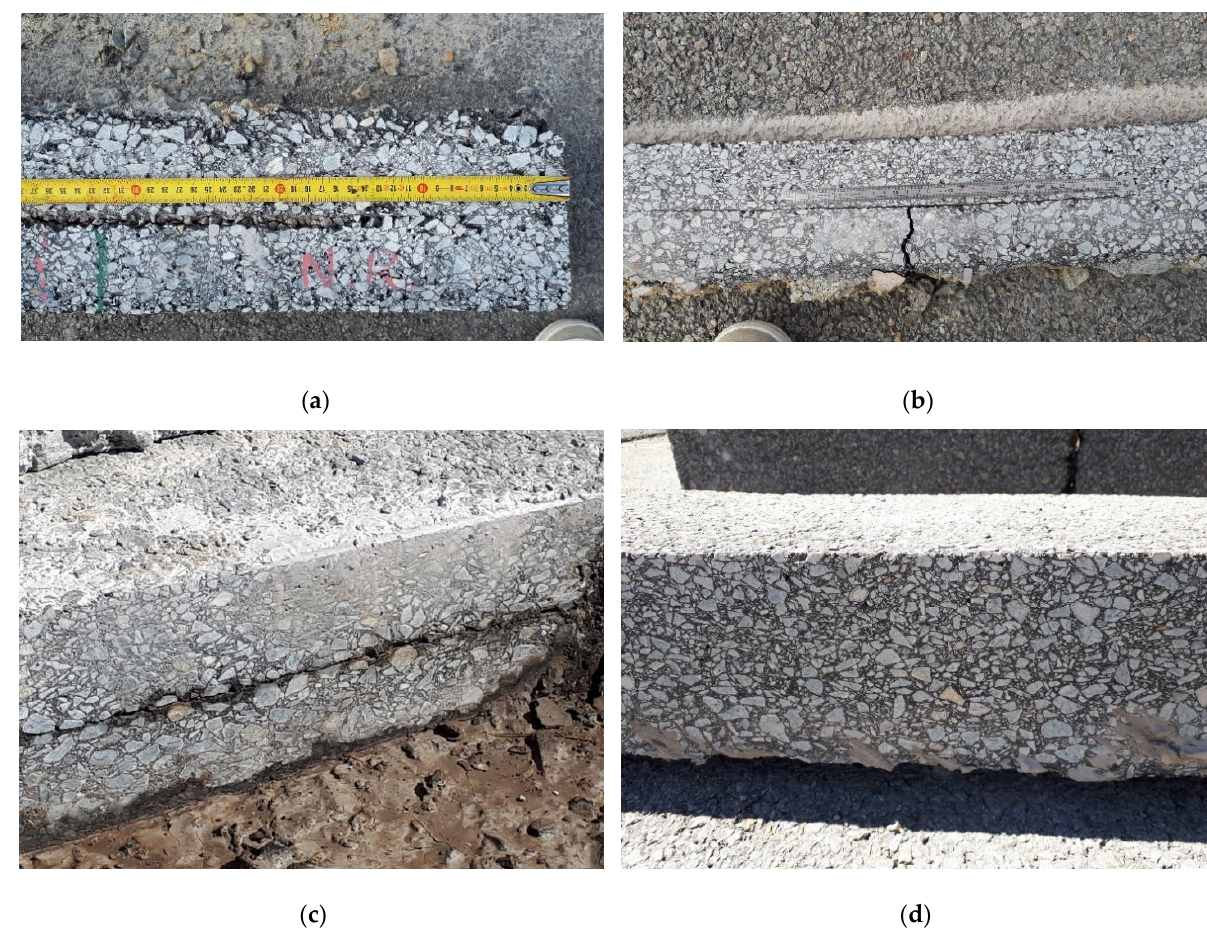
Figure 40. Details of defects visible on the side of asphalt slabs, based on ( a ) sand (I-11), ( b ) geotextile (I-10), ( c ) tack-coat free (I-13), and ( d ) healthy zone.